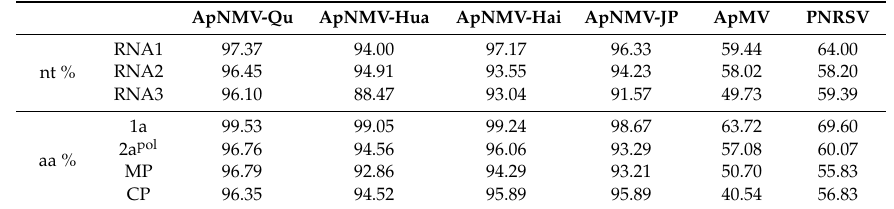
Table 1. Sequence similarity of ApNMV–Lw with other ApNMV isolates, apple mosaic virus (ApMV), and prunus necrotic ringspot virus (PNRSV).